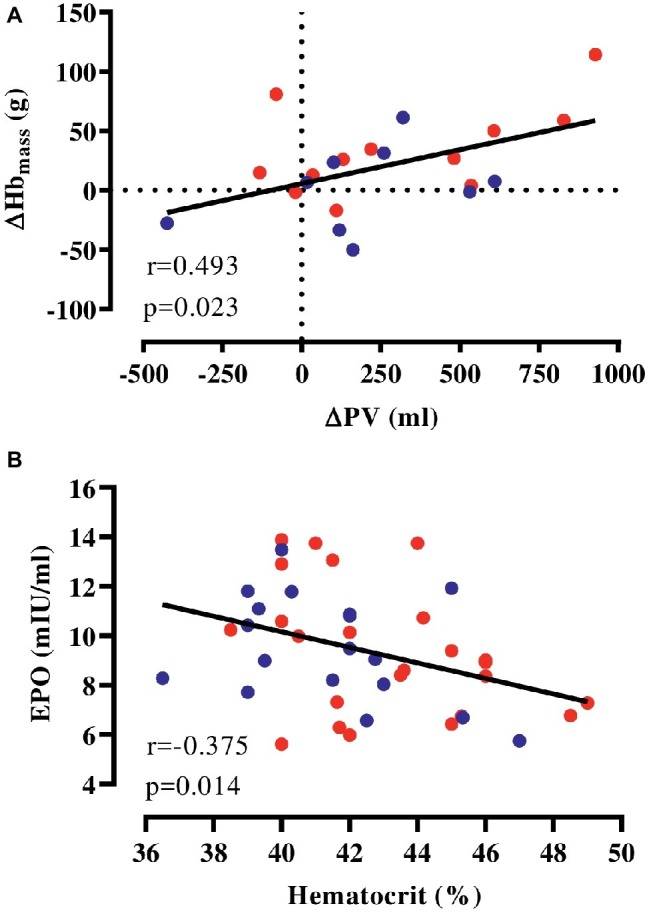
Correlation of hematological parameters. (A) Changes in Hbmass and PV with the intervention (HEAT: red, CON: blue), (B) absolute EPO and hematocrit (values before and after the intervention pooled). EPO, erythropoietin; Hbmass, hemoglobin mass; PV, plasma volume.